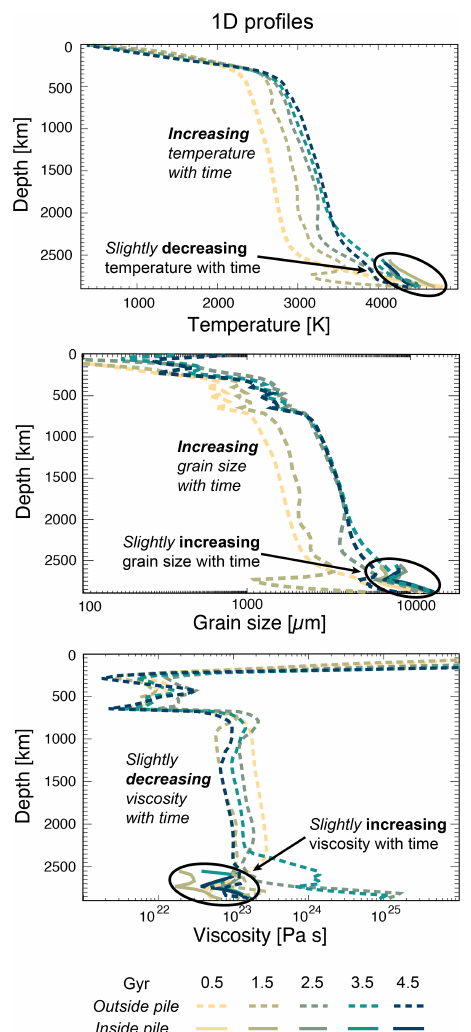
Figure 7. 1D profiles through the whole model domain of simu- lation no. 73. The dashed lines show the average values of crust and ambient mantle for five time steps of the model evolution. The darker the colour, the later the time step. The solid curves show av- erage properties within the pile for the same time steps. Top: tem- perature, middle: grain size, bottom: